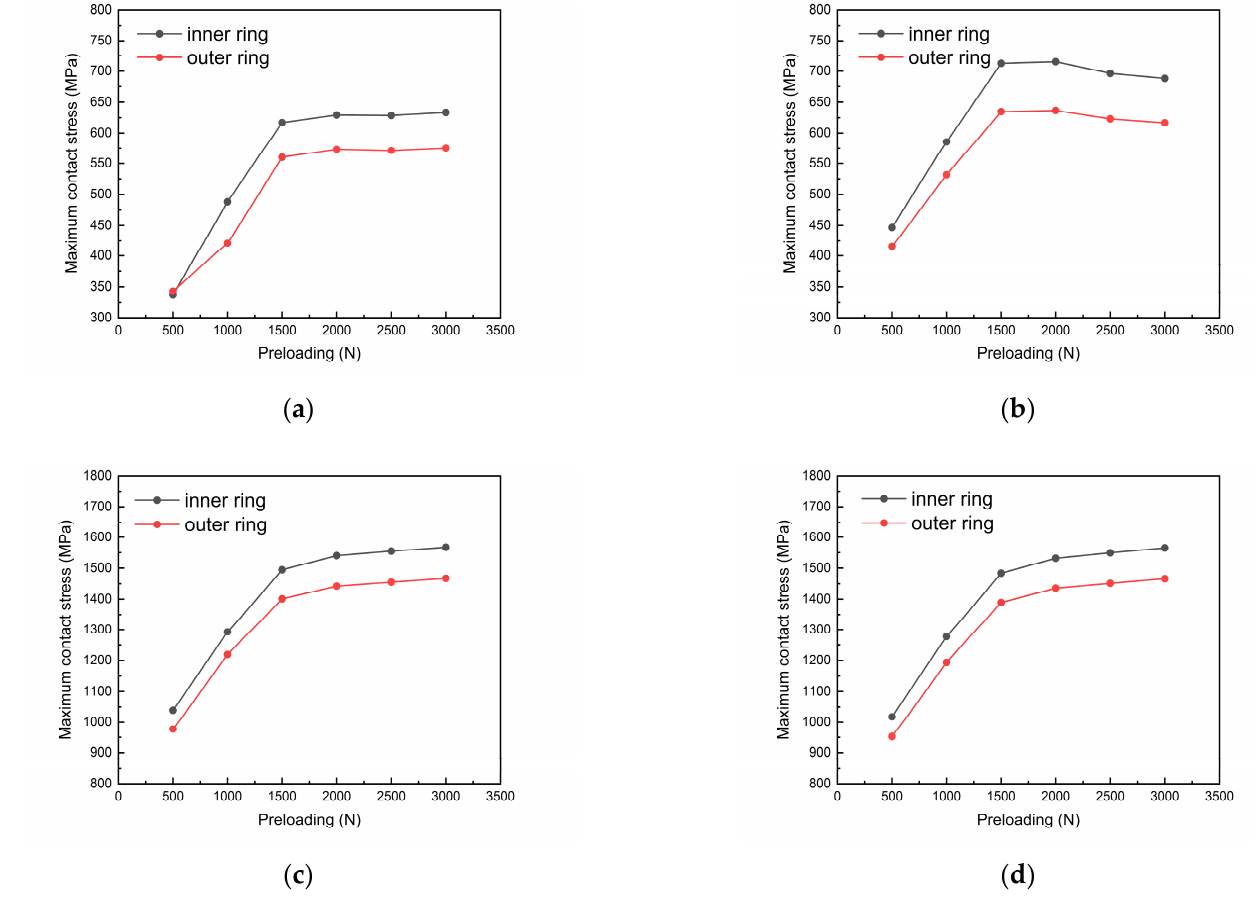
Figure 12. The relationship curve between maximum contact stress of inner/outer ring and preload of spindle. ( a ) Rolling bearing 1. ( b ) Rolling bearing 2. ( c ) Rolling bearing 3. ( d ) Rolling bearing 4.